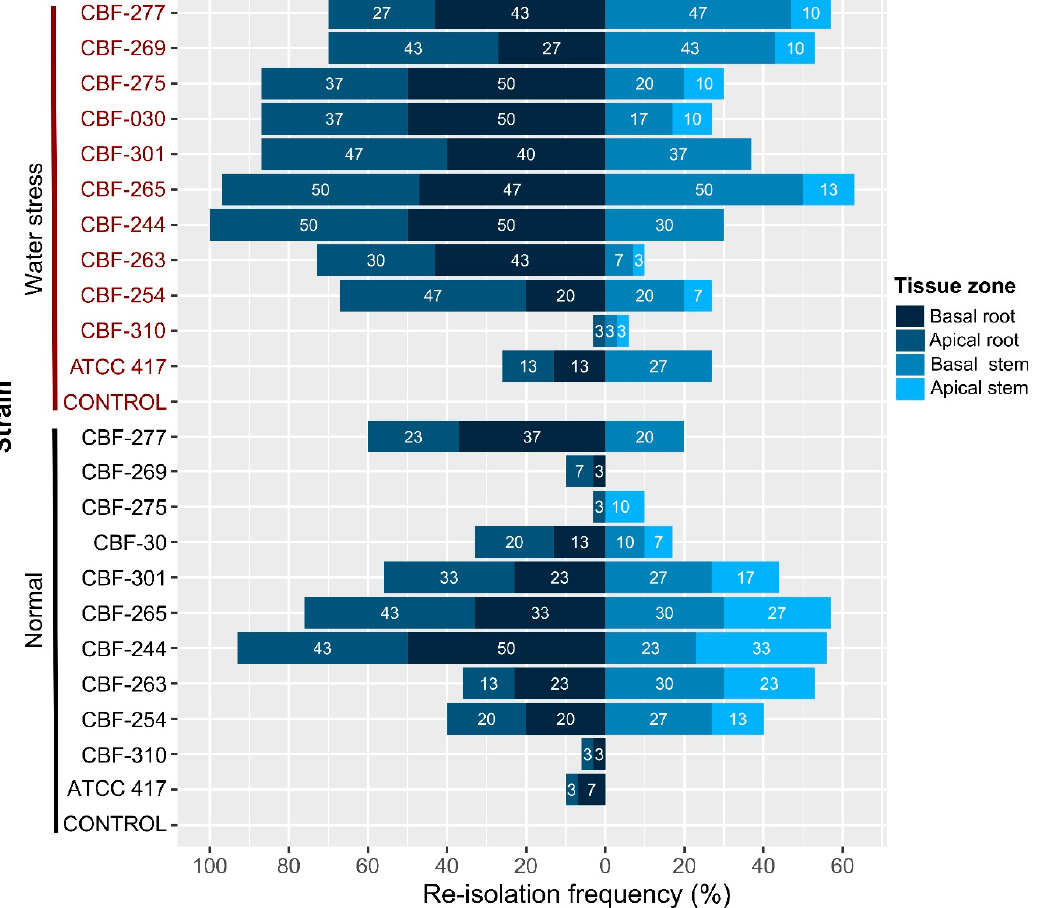
Figure 6. Re-isolation frequency of Fusarium isolates from roots and stem tissues after 45 days of post-inoculation. Fusarium isolates were reisolated of basal and apical zones of both root and stem tissues. The identification of re-isolates was determined by amplification and sequencing of either EF-1 α or RPB2 gene. Sequences were compared against sequences obtained previously for all the isolates.